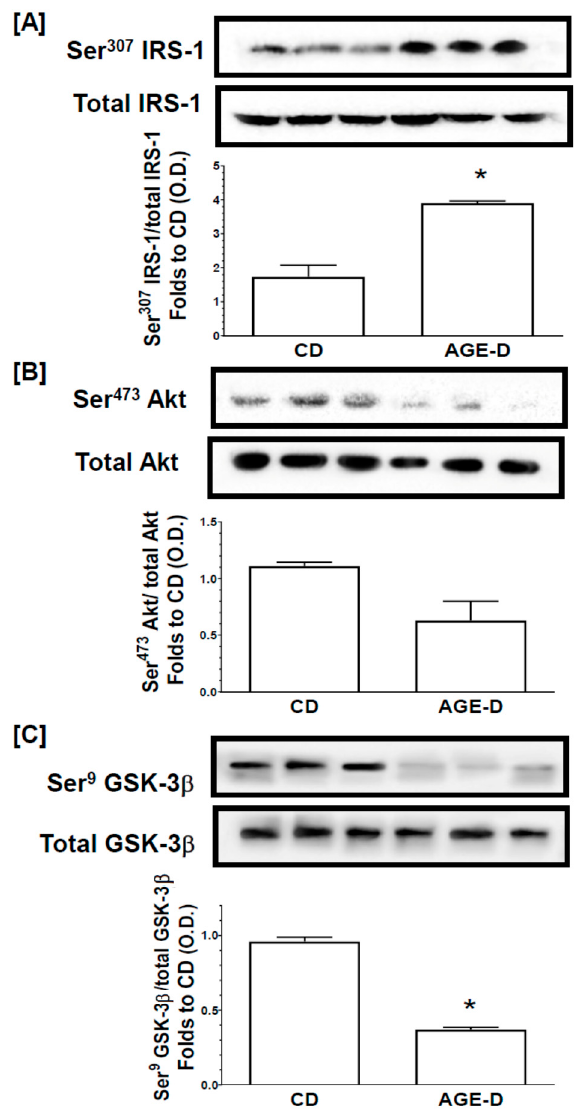
Figure 8. Assessment of insulin signal transduction in the gastrocnemius muscle through the Western blotting analysis of the phosphorylation rate of ( A ) IRS-1, ( B ) Akt, ( C ) GSK-3 β . Histograms report the densitometric analysis represented as the ratio between phosphorylated-to-total protein amount and expressed as fold of CD value. Data are means ± S.E.M. ( n = 15 per group). Statistical significance: * p < 0.05 vs.